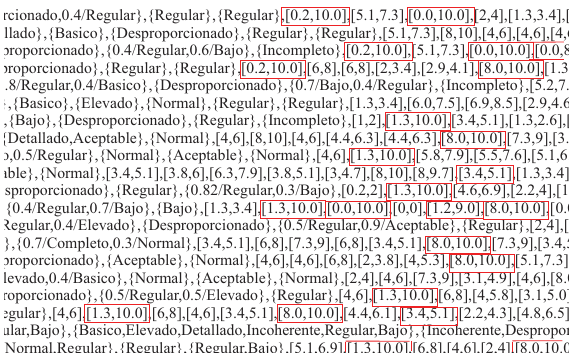
Fig. 12. A part of transformed “Inexpert-57.dat” dataset